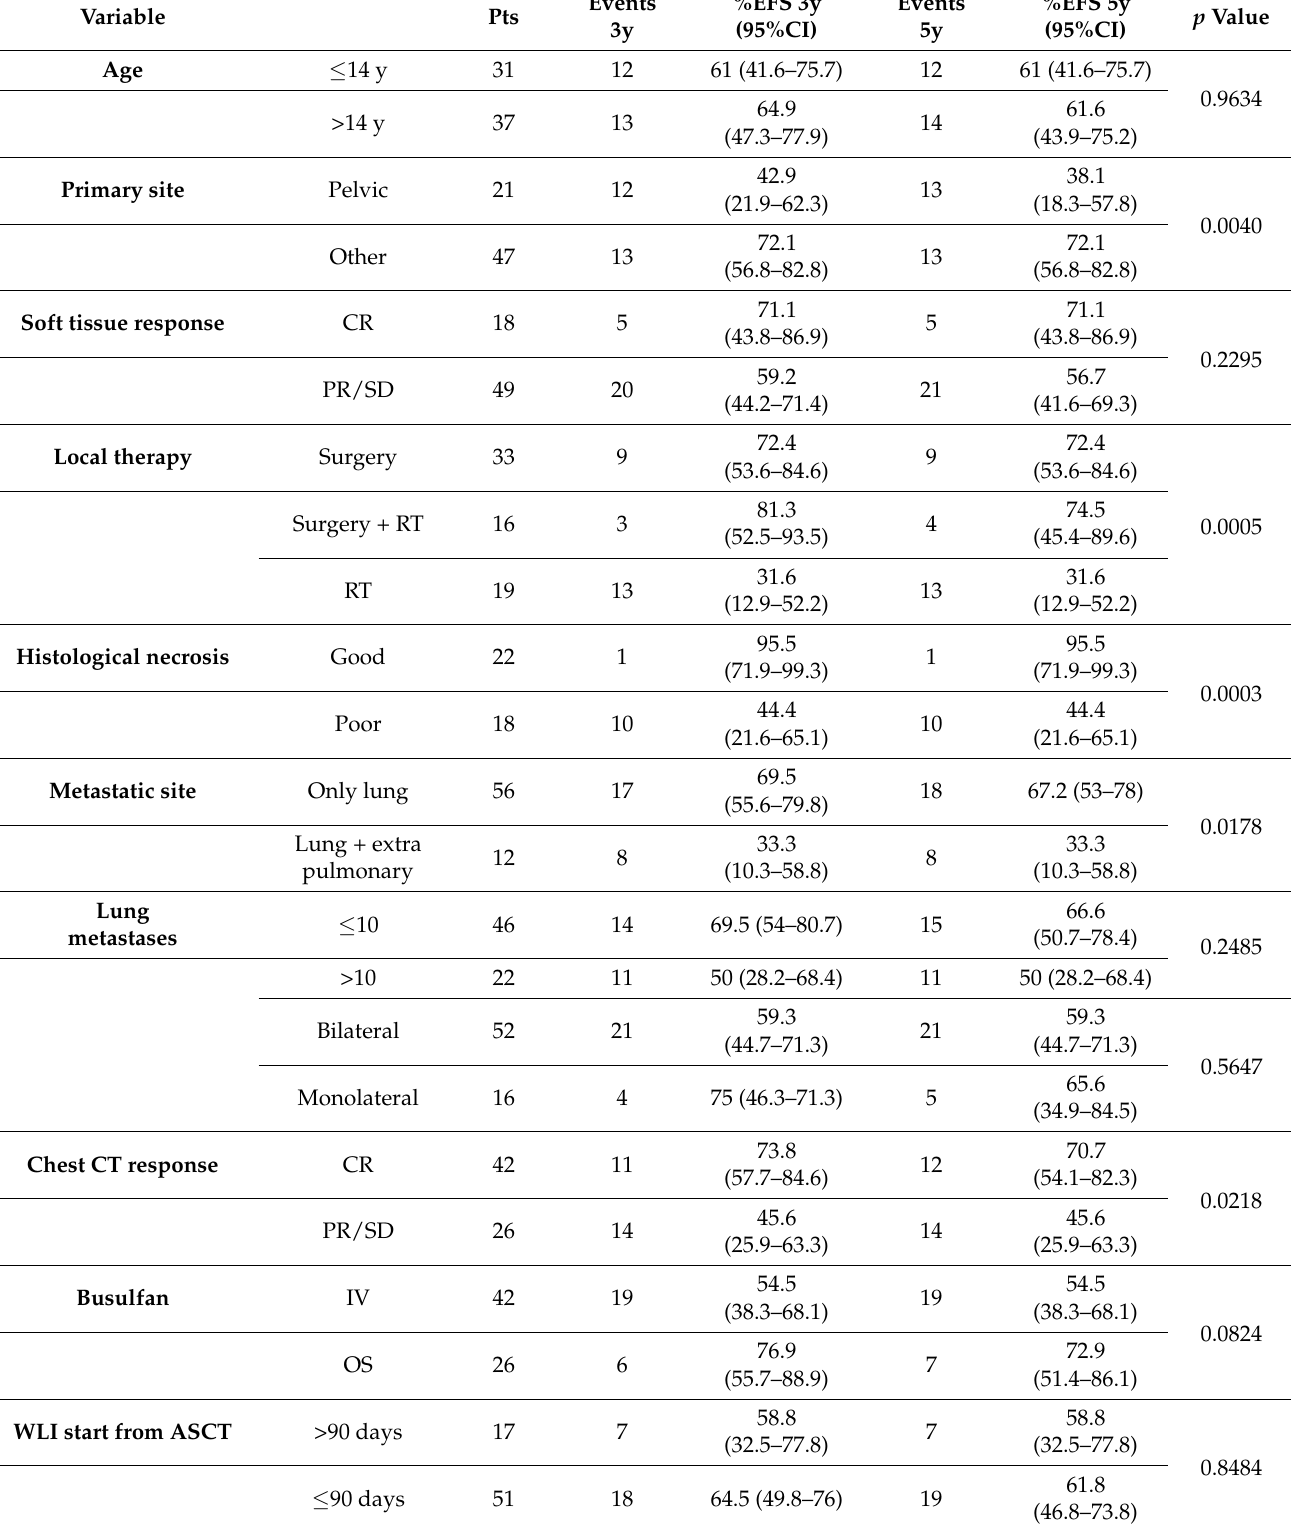
Table 5. Univariate analysis for event-free